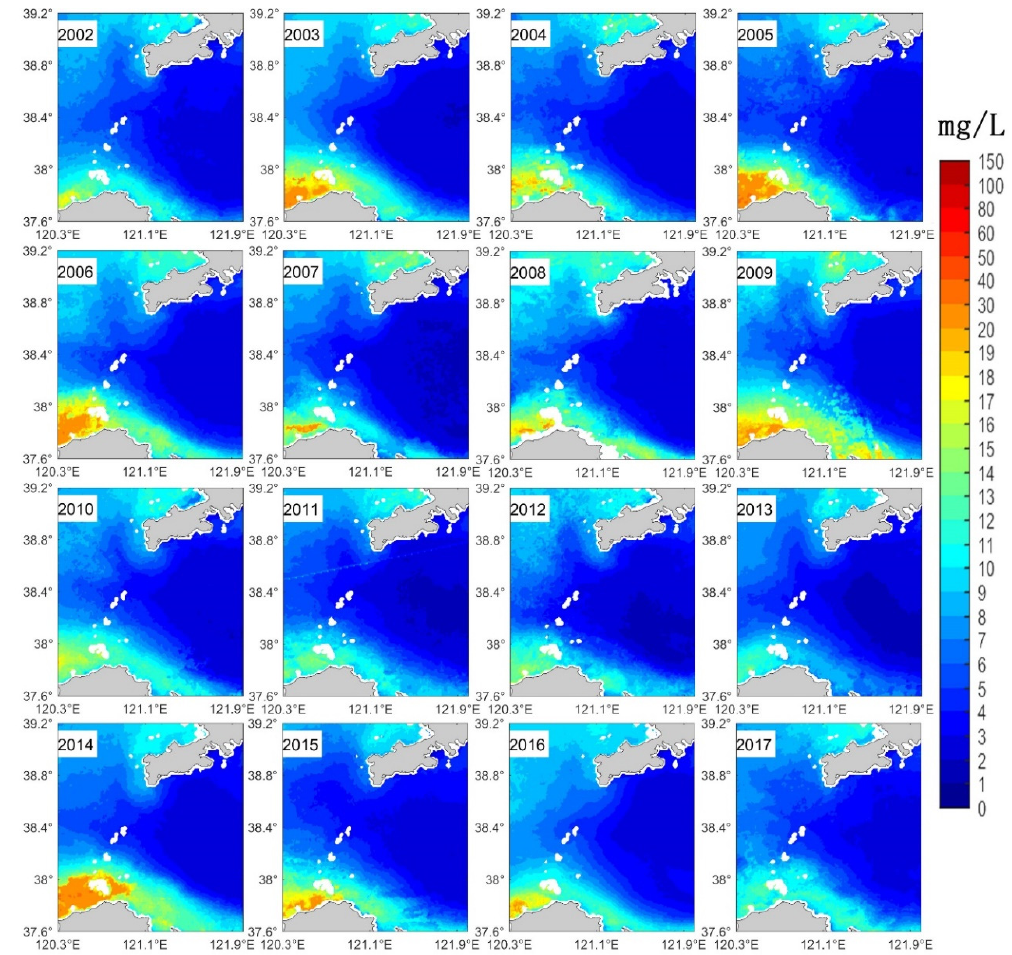
Figure 7. Multi-year variations in the surface SSC in the Bohai Strait.